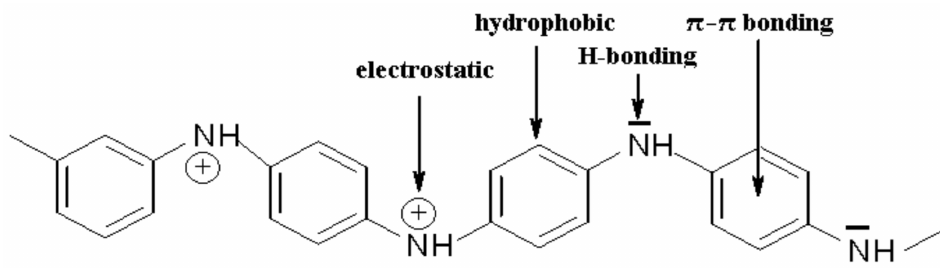
Figure 2. Types of interactions on polyaniline. PANI can be found in various forms with different colors depending on acid – base conditions and oxidation states: leucoemeraldine (colorless), emeraldine (salt-green/base- blue), and pernigraniline (salt-blue/base-violet). Pernigraniline is the fully oxidized form, emeraldine is the half-oxidized form (the most stable), and lecomeraldine is the reduced form of PANI. In acidic conditions, the PANI hydrophobic non-conducting base is converted to hydrophobic conducting salt (Figure 3) [1–3].